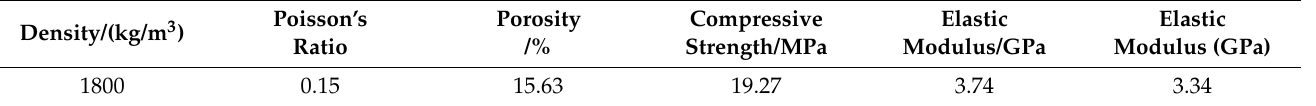
Table 2. Parameters of the grey